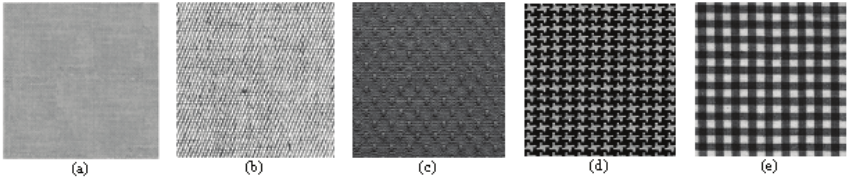
Figure 1. Fabric examples: (a) Plain fabric (p1 group); (b) Twill fabric (p1 group); (c) Dot-patterned fabric (pmm group); (d) Star-patterned fabric (p2 group); (e) Box- patterned fabric (p4m